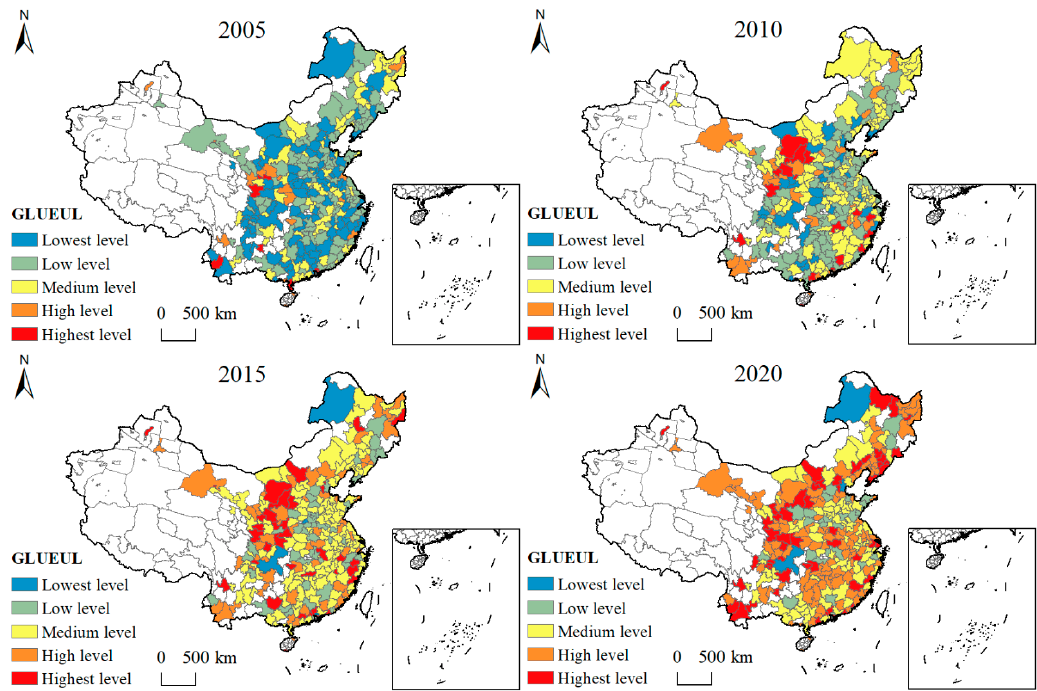
Figure 3. The characteristics of the spatial pattern of GLUEUL from 2005 to 2020 .